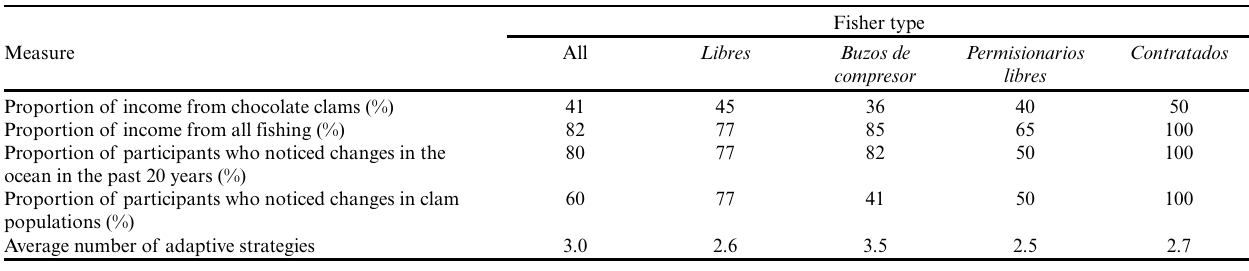
Table 4. Measures related to fishers’ proportional economic dependence on chocolate clam fishing and on all fishing, proportion of fishers who have noticed changes in the ocean and in clam populations, and average number of strategies employed by fishers. Each measure is presented for the entire participant pool and for each fisher type. These measures were calculated from the responses of 35 fishers to questions presented during semi-structured